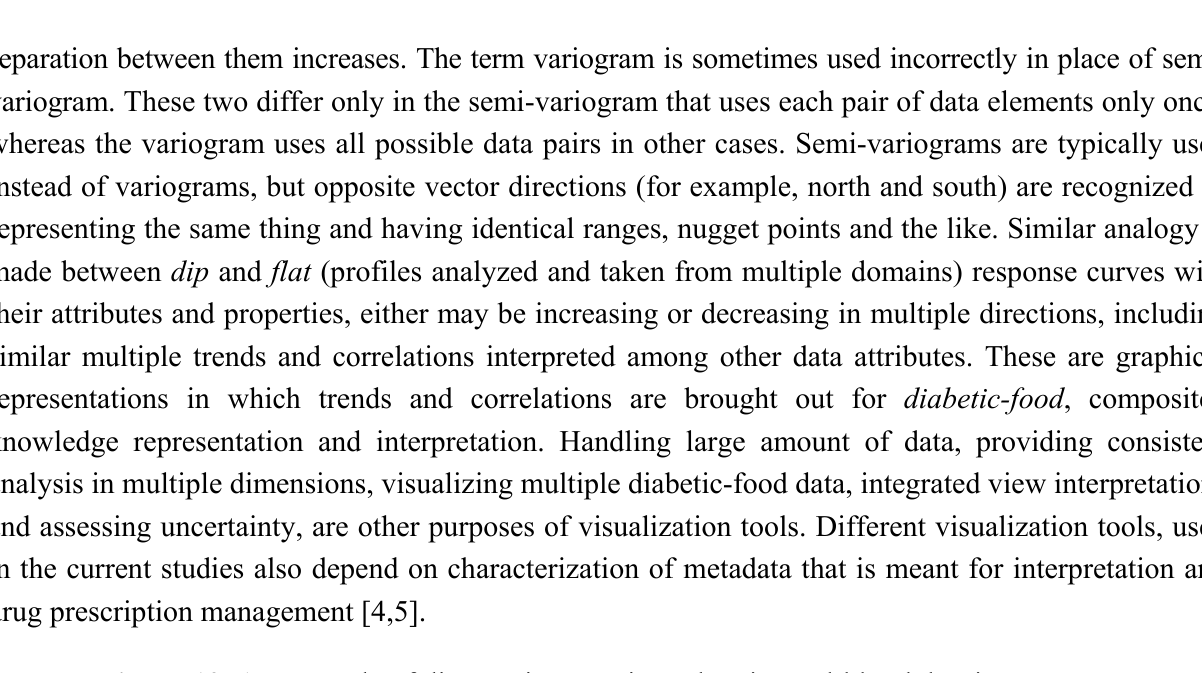
Figure 13. An example of diagnostic map view, showing red-blood density